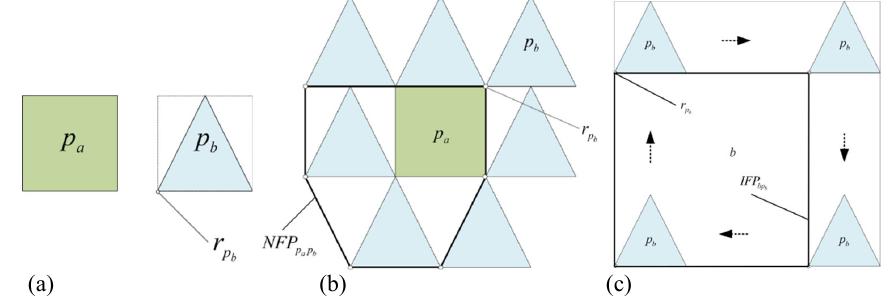
NFP , (c) The generation process a b p p